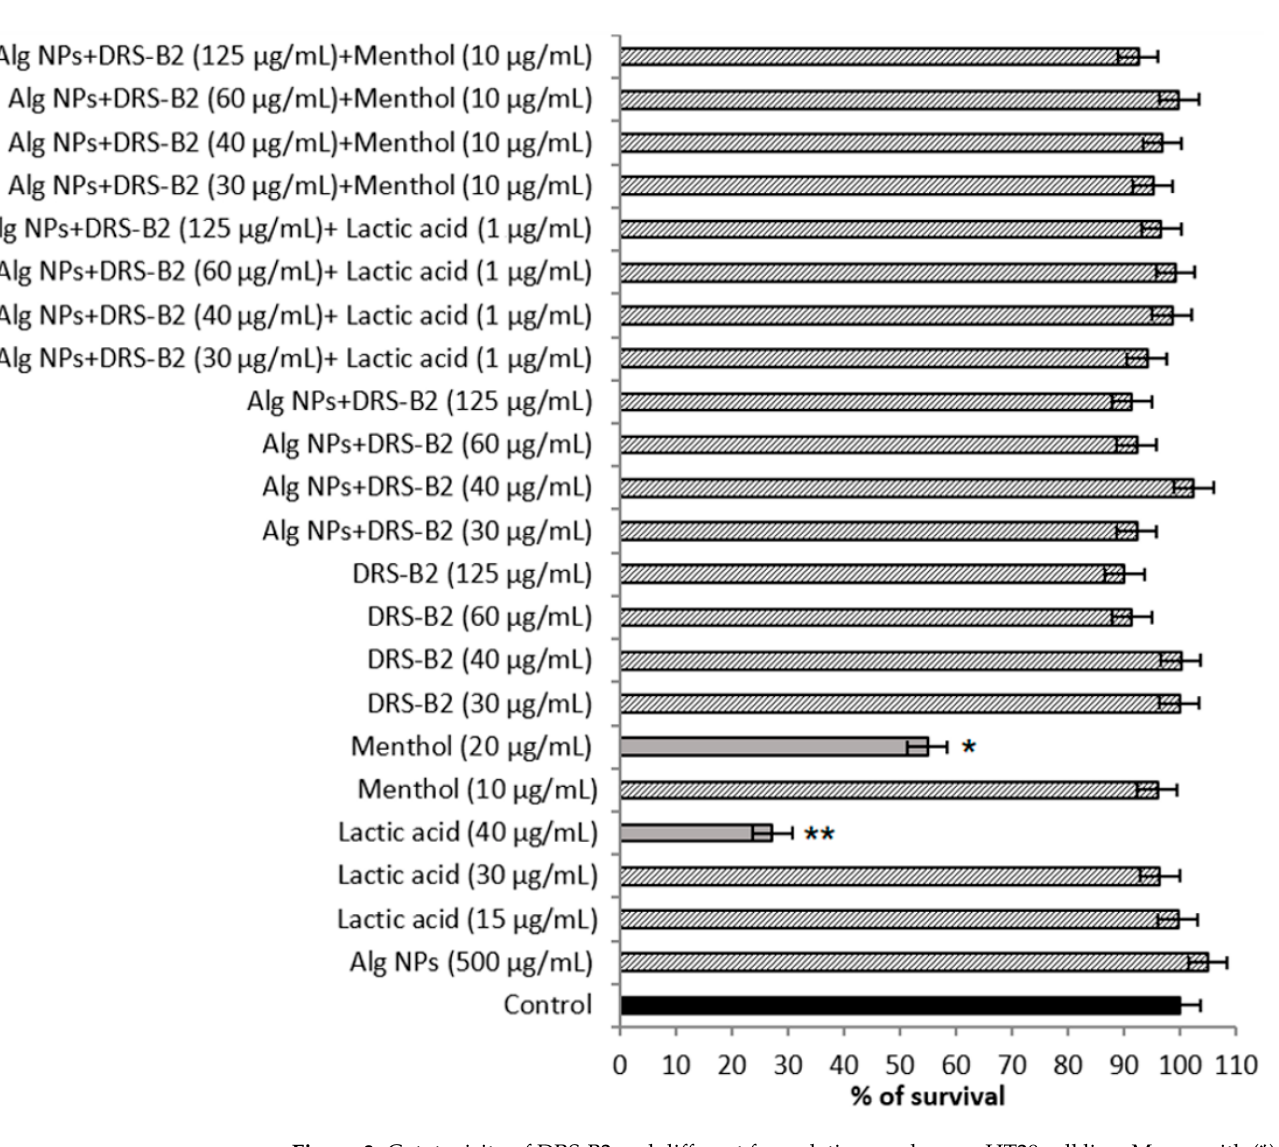
Figure 3. Cytotoxicity of DRS-B2 and different formulations on human HT29 cell line. Means with ( * ) or ( ** ) are significantly different from control and between them ( p < 0.05).